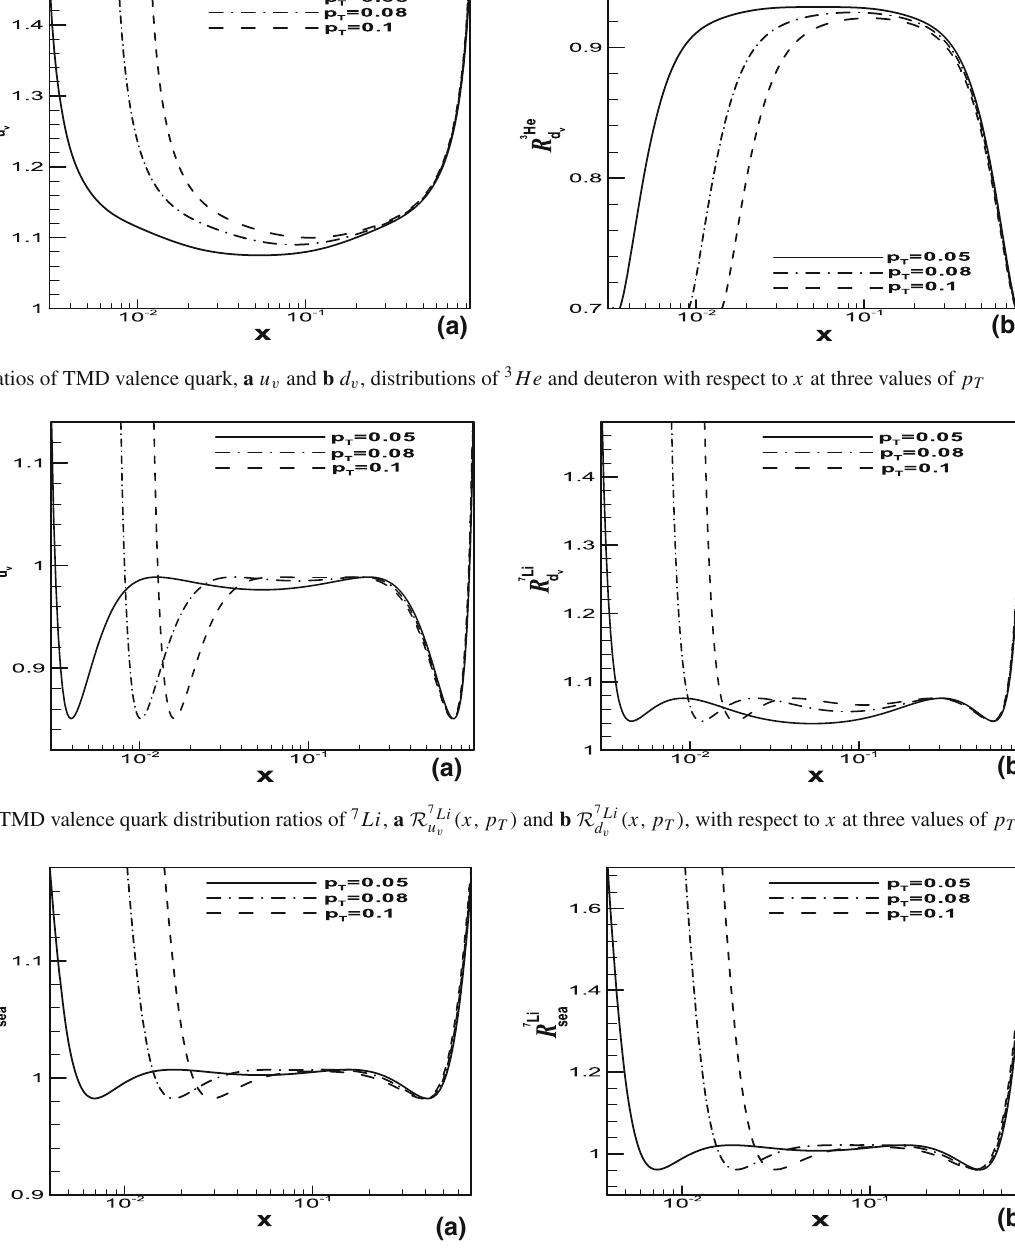
Fig. 11 The ratios of TMD total sea quark distributions of a 3 He , b 7 Li to those of deuteron with respect to x at three values of p T in Figs. 1 and 2, they take different values at each value of x